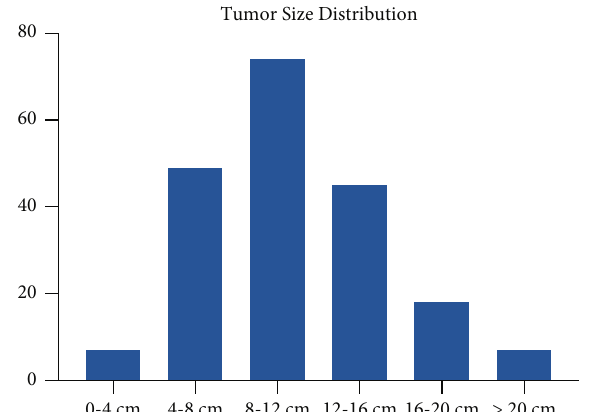
Figure 2: Tumor size histogram for osteosarcoma of the pelvis. The median tumor size was 11.0cm and was the largest among surveyed anatomic